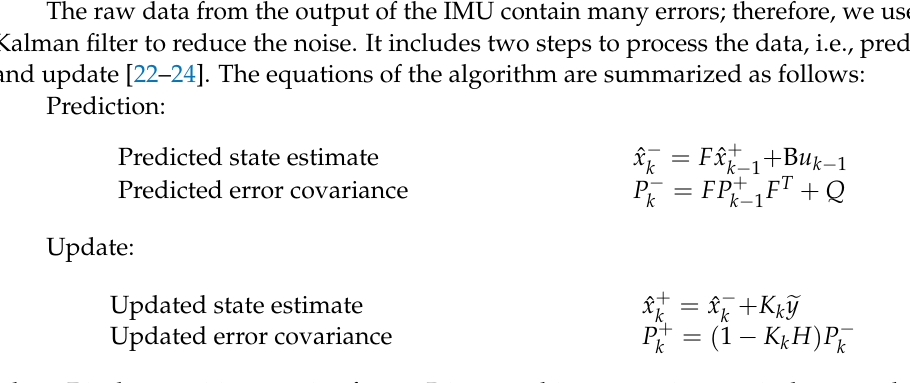
Figure 4. Distribution of angle parameters for six modes (1 = Bicep, 2 = Deltoid, 3 = Tricep, 4 = Shoulder, 5 = Squat, 6 = Side and lunge).